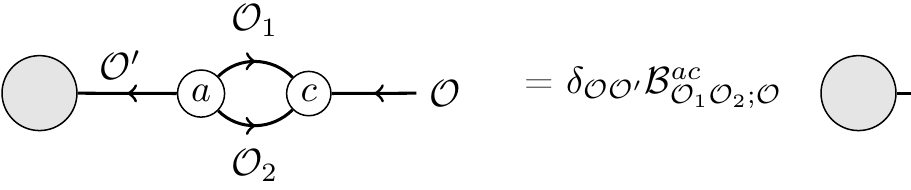
Figure 4 . We de(cid:12)ne the bubble annihilation matrix as shown in the (cid:12)gure, where we suppress its B possible dependence on and . One can explicitly calculate by removing the gray blob above O 1 O 2 B and connecting both ends: this relates times Plancherel measure to pairing of two three-point B functions, which can then be calculated by going to a (cid:12)xed conformal frame and carrying out the explicit calculations. A similar calculation is carried out in 4 d in [29], see appendix C there. Here we repeated it for 3 d